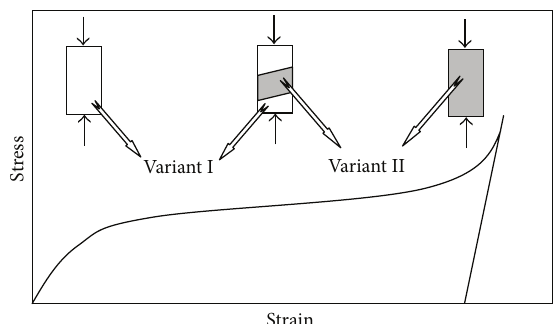
Figure 1: A schematic for microstructure evolution and corre- sponding stress-strain behavior of magnetic shape memory alloy in martensite during the loading